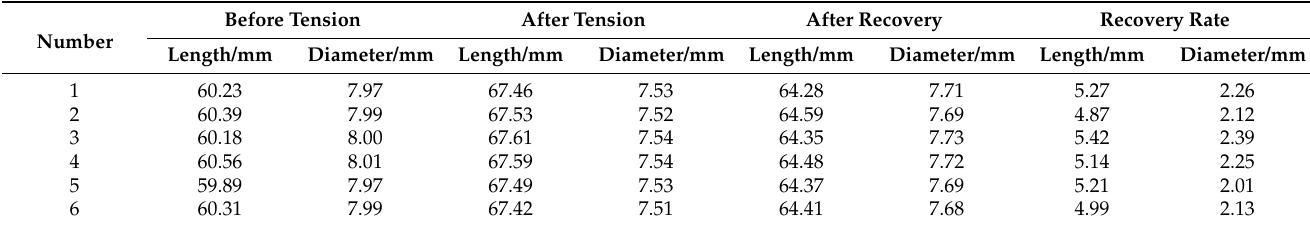
Table 4. Size of the standard distance section of tensile specimens.